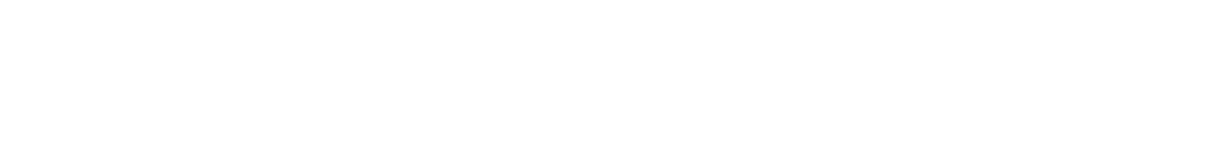
Frontiers in Communication |